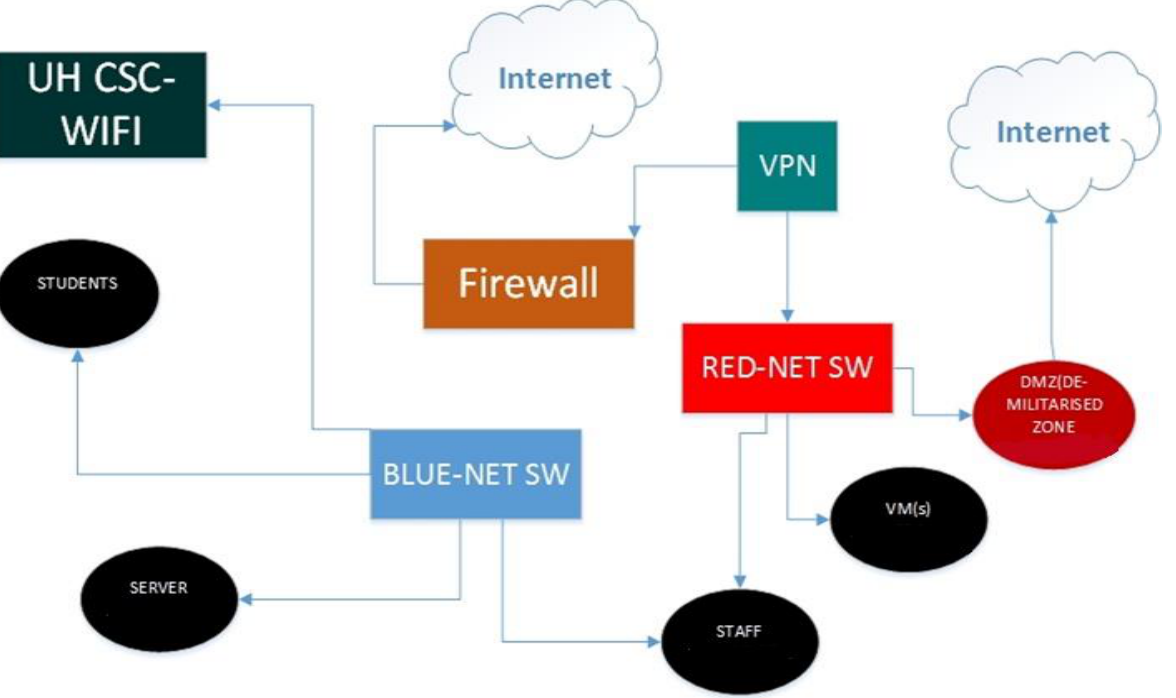
Figure 1. Penetrating Testing Setup at Cybersecurity Laboratory.